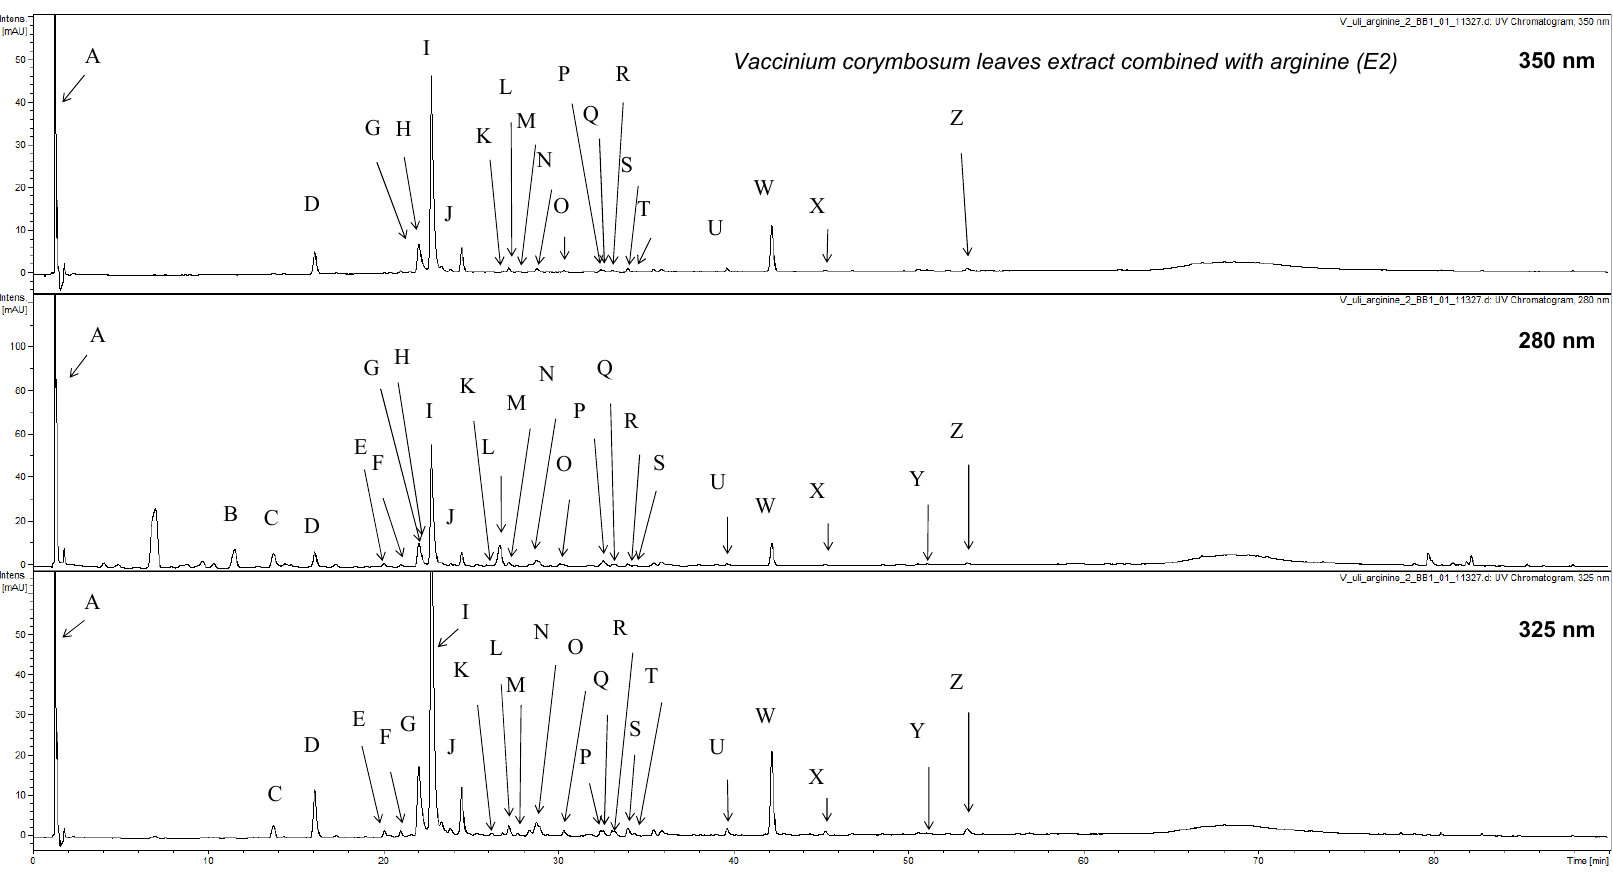
Figure 2. HPLC-DAD-MS chromatogram of E2 recorded at 350, 280 and 325 nm.